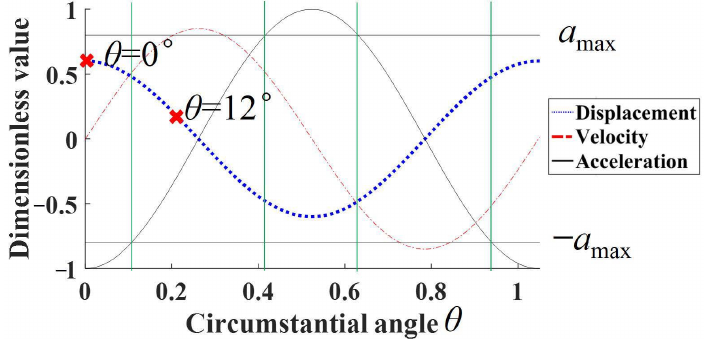
Figure 5. Schema of motion of structure with 6 ND at t = 0 (two positions).